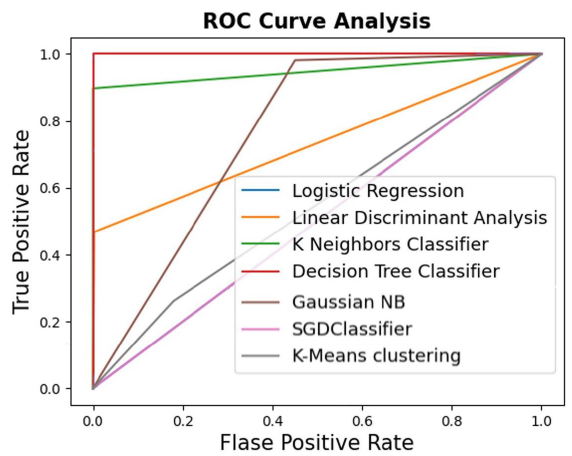
Figure 18. The ROC curves of ML models